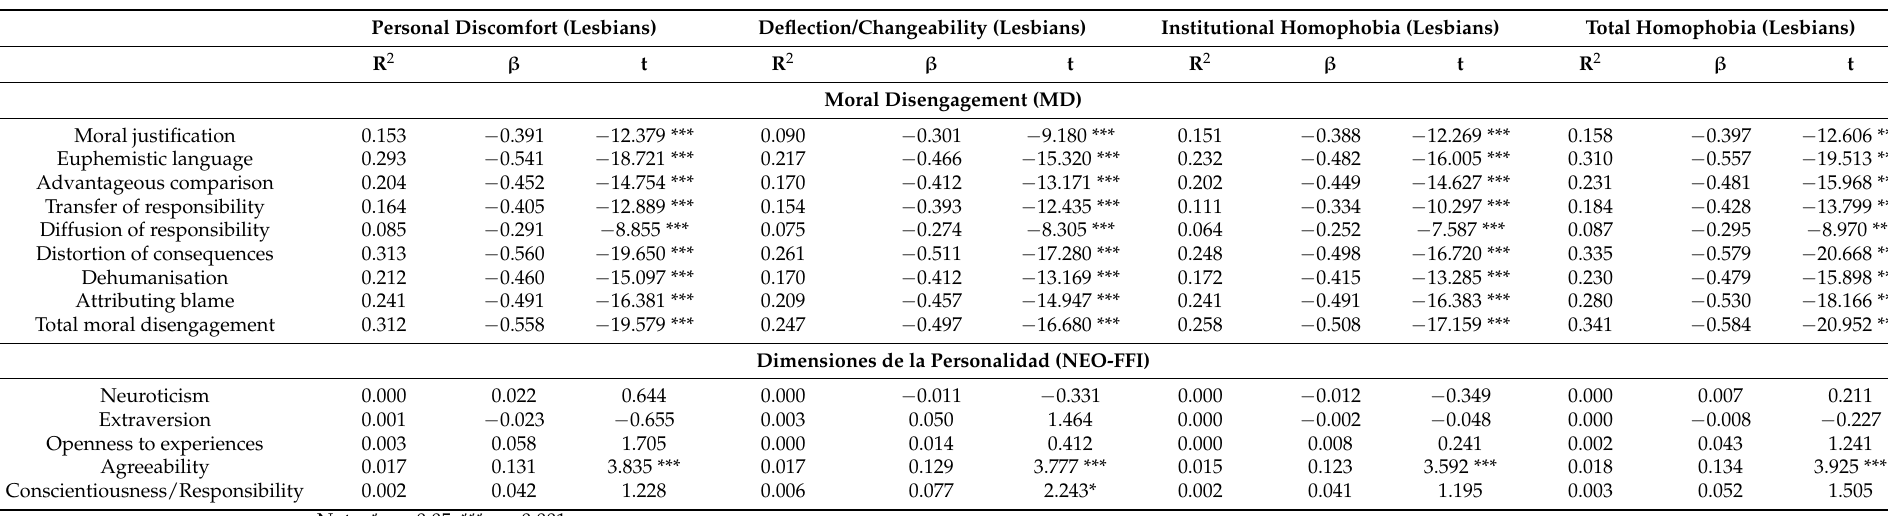
Table 4. Linear regression of modern homophobia towards the lesbian collective with respect to moral disengagement and personality